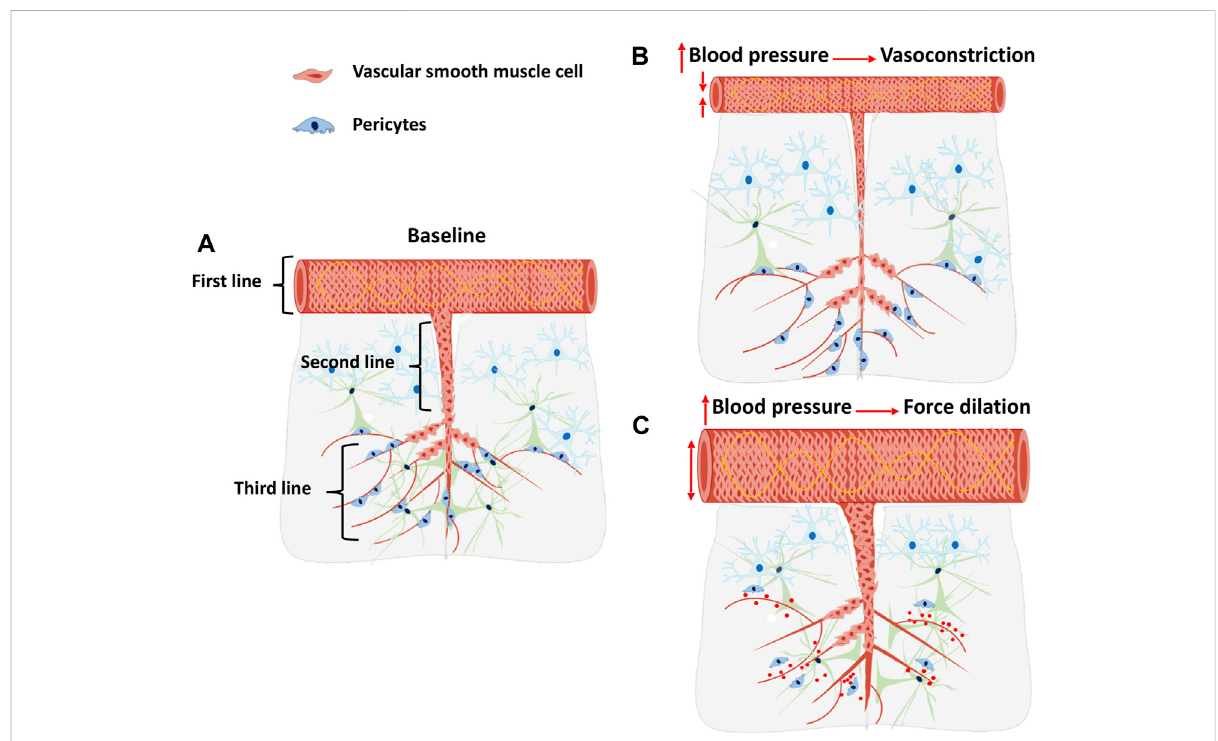
FIGURE 2 CBF Autoregulation: A three lines of defense?, A cartoon illustrates the three lines of defense of CBF autoregulation and the consequences of impaired CBF autoregulation. (A) Cerebral pial arteries and arterioles at a basal level under baseline blood pressure. (B) Cerebral pial arteries and arterioles constrict in response to elevated blood pressure. (C) Cerebral pial arteries and arterioles force dilated in response to elevated blood pressure due to an impaired myogenic response. The impaired CBF autoregulation may contribute to pericytes detachment, capillaries damage, microvessels rarefaction, and blood-brain barrier